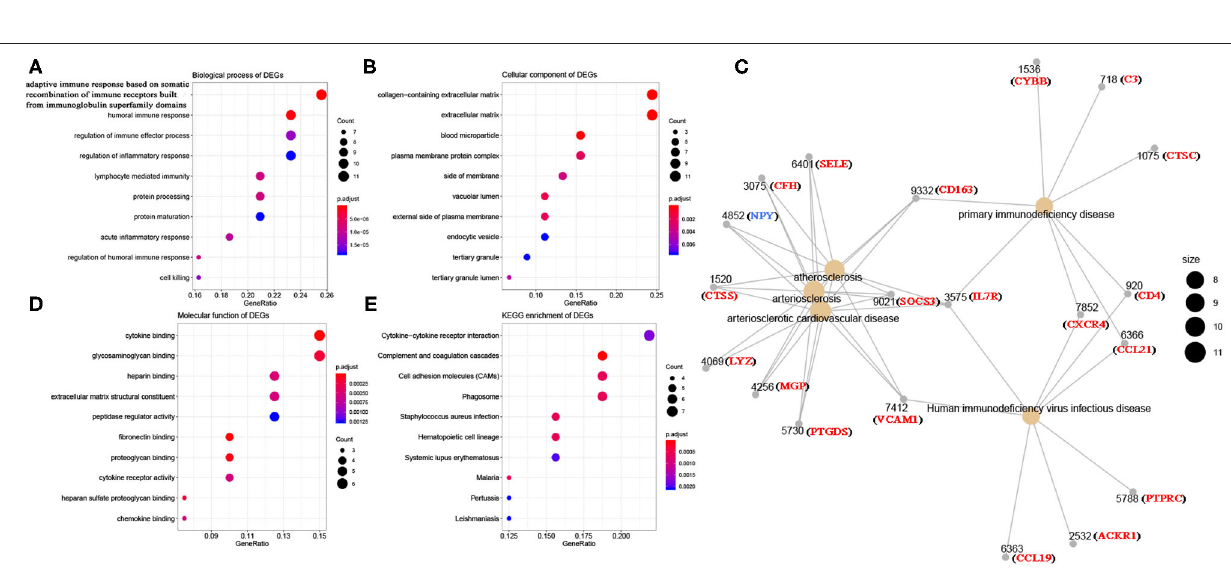
Frontiers in Oncology | www.frontiersin.org